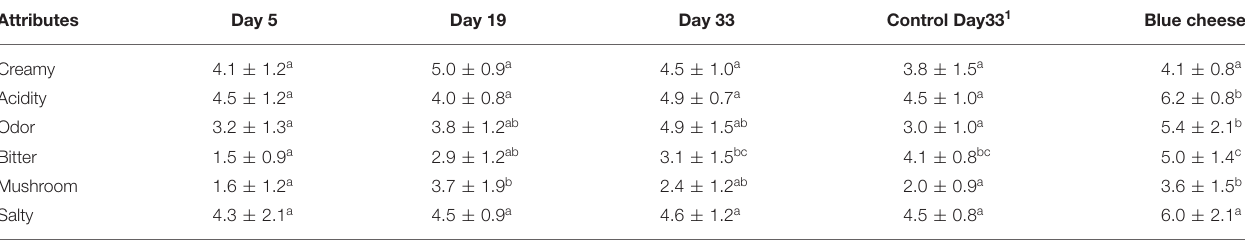
TABLE 5 | Sensory evaluation of the Red-Veined Cheese during ripening and commercial Blue cheese (President brand). Attributes Day 5 Blue cheese Creamy